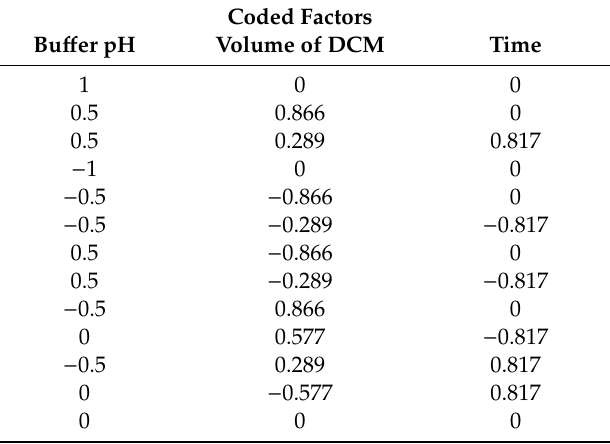
Table 2. The Doehlert Design.